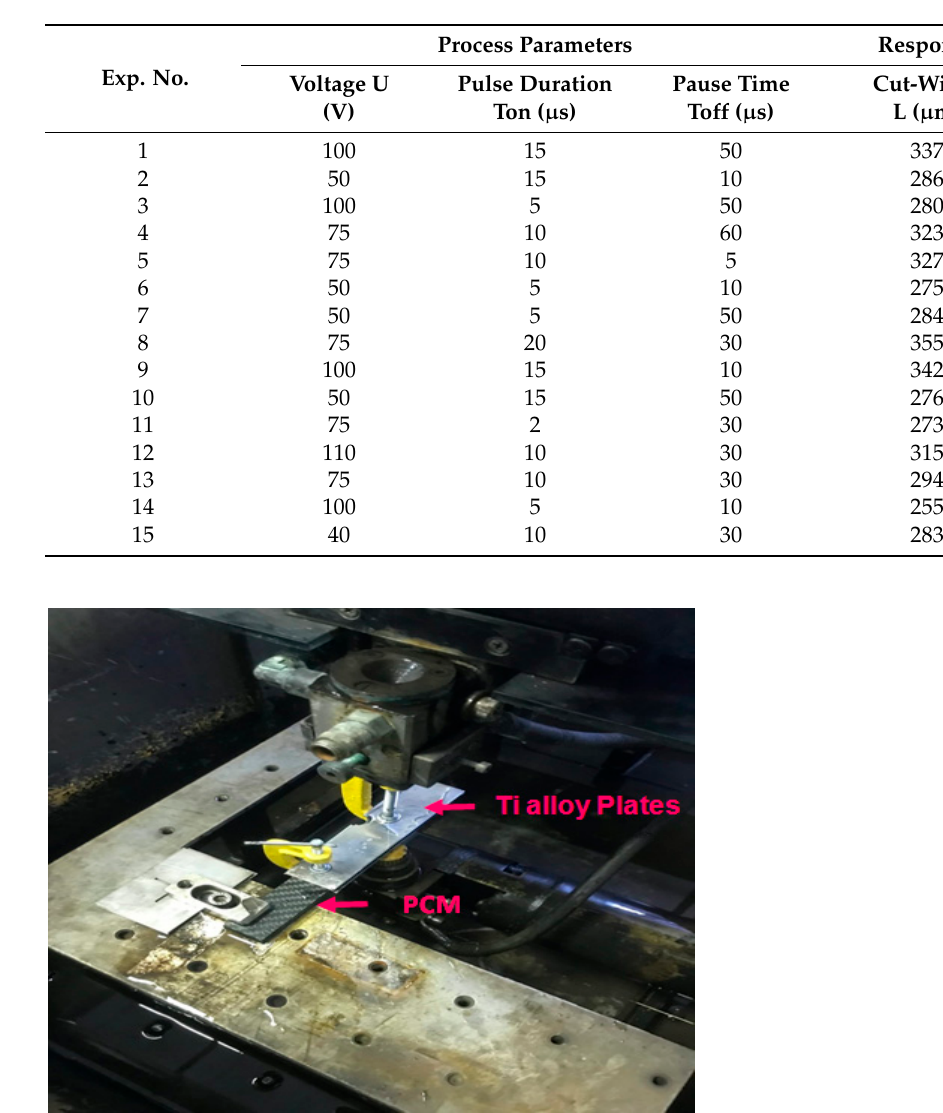
- Table 5. Analysis of variance (ANOVA) of process parameters for 2-way interaction model . ANOVA for Response Surface Source